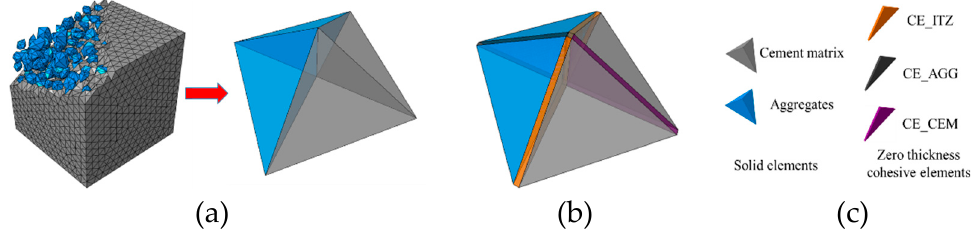
Figure 4. Insertion of the cohesive elements into the interfaces of the solid elements: ( a ) initial mesh of the two-phase structure, ( b ) the mesh with zero thickness cohesive elements, ( c ) element types in the mesh.